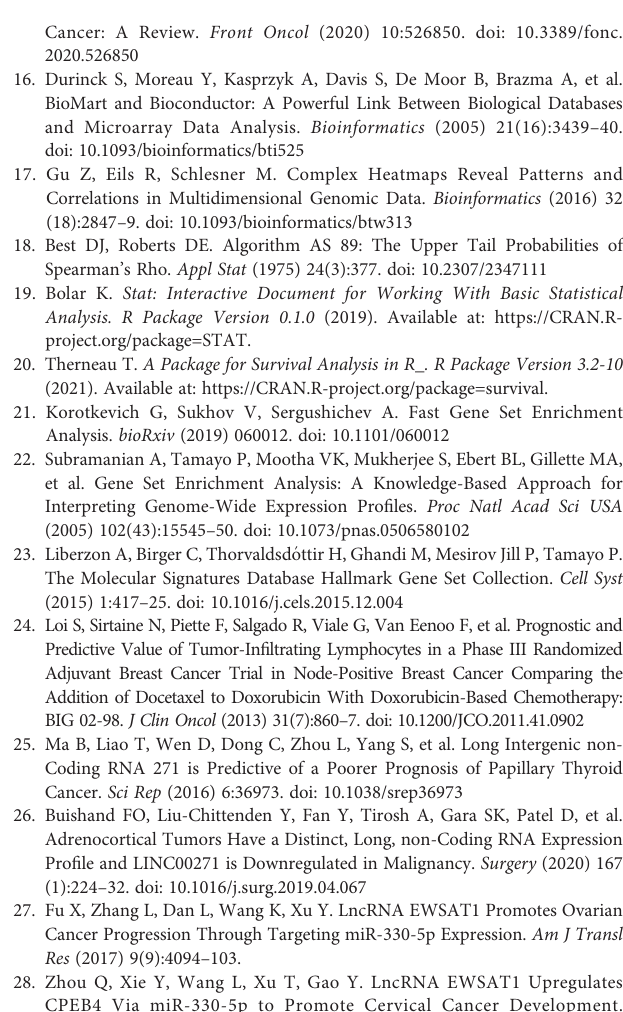
Supplementary Figure 2 | Venn diagram representing speci fi c and shared immune related lncRNAs in breast cancer (BRCA) molecular subtypes after fi ltering Supplementary Figure 3 | Enrichment map for immune-related lncRNA signature for each molecular subtype: (A) Basal, (B) LumA, (C) LumB, (D) Normal, and (E) Her2. The lncRNAs are organized in the X axis and Hallmarks gene sets in the Y axis. Red circles refer to positive enrichment scores while blue circles to negative. The circle size varies according to -log10 (adjusted p-value), bigger circles mean greater signi fi cance.